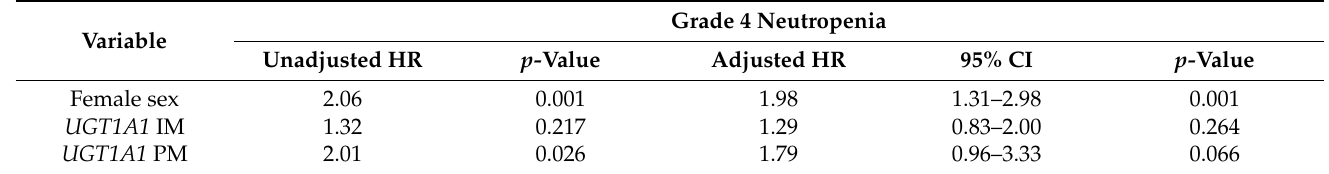
Table 6. Multivariate analysis using Cox regression analysis to identify risk factors for grade 4